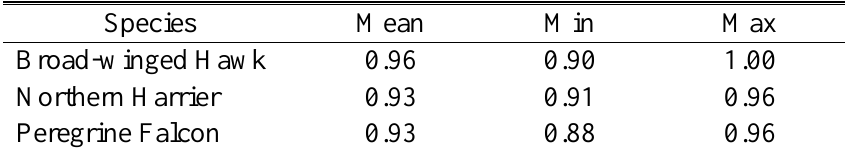
Table A3.1. Mean, min and max of Pearson correlation of qq-scores between real and simulated migration count datasets (n = 100) for a common (Northern Harrier), rare (Peregrine Falcon) and overdispersed (Broad-winged Hawk) raptor species. A Pearson correlation near 1 suggests a comparable distribution of counts between datasets. In all cases, p < 0.0001. Real data were collected at Hawk Mountain Sanctuary, Pennsylvania (1991-2010).